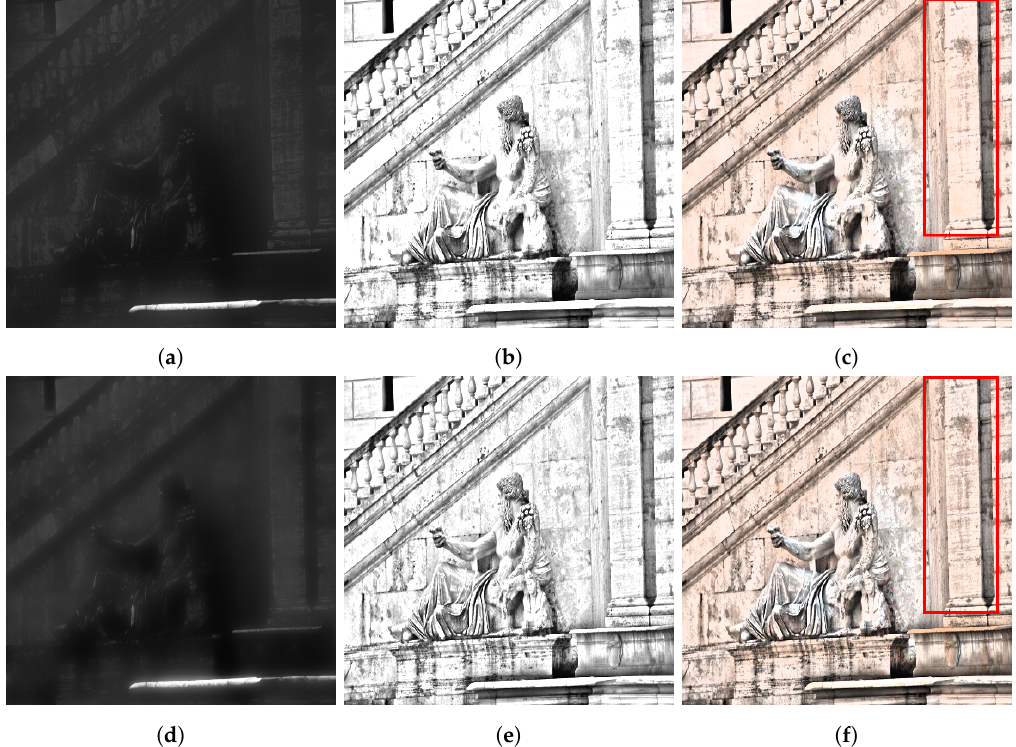
Figure 2. The result of applying the Retinex algorithm from the single image dictionary in Figure 1: ( a ) SCR [17] illumination; ( b ) SCR reflectance; ( c ) Image enhancement through SCR; ( d ) CSC Retinex [18] illumination; ( e ) CSC Retinex reflectance; ( f ) Image enhancement through CSC